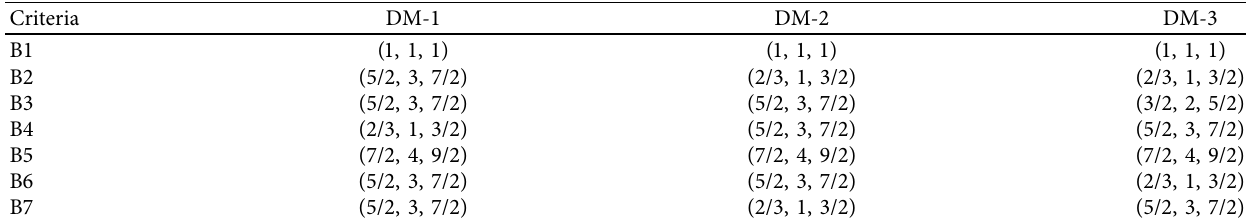
Table 7: TFNs are used to prioritize all other criteria above the poorest criterion (others-to-worst vector). Criteria